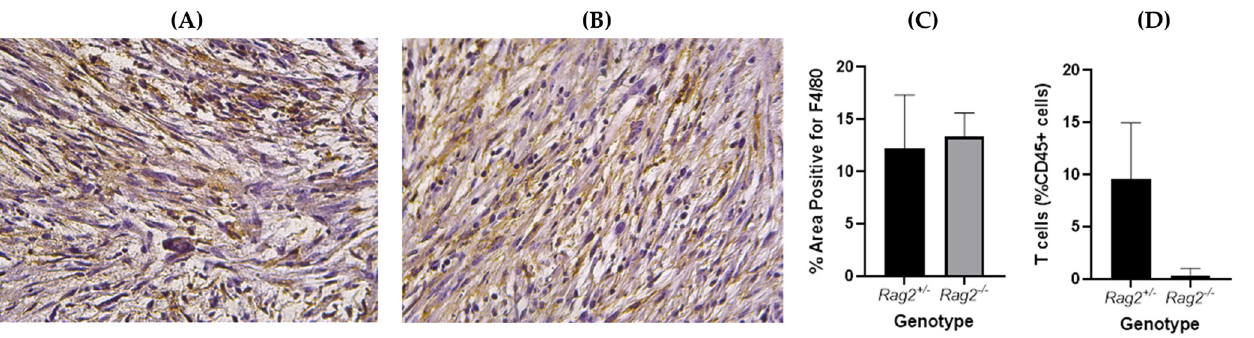
Figure 9. Representative immunohistochemistry slides of sarcoma tumors in ( A ) Rag2 − / − , ( B ) Rag2 +/ −